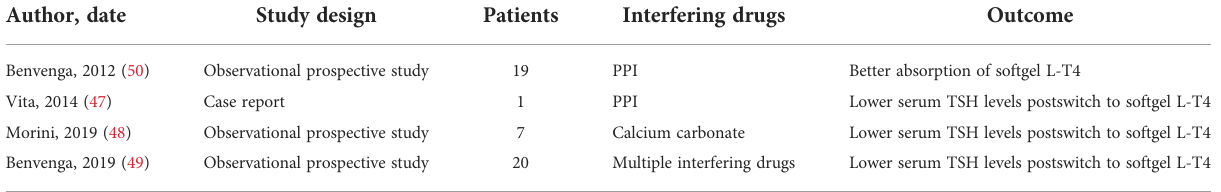
TABLE 2 Summary of clinical studies and case reports about softgel capsules L-T4 formulations and interfering absorption